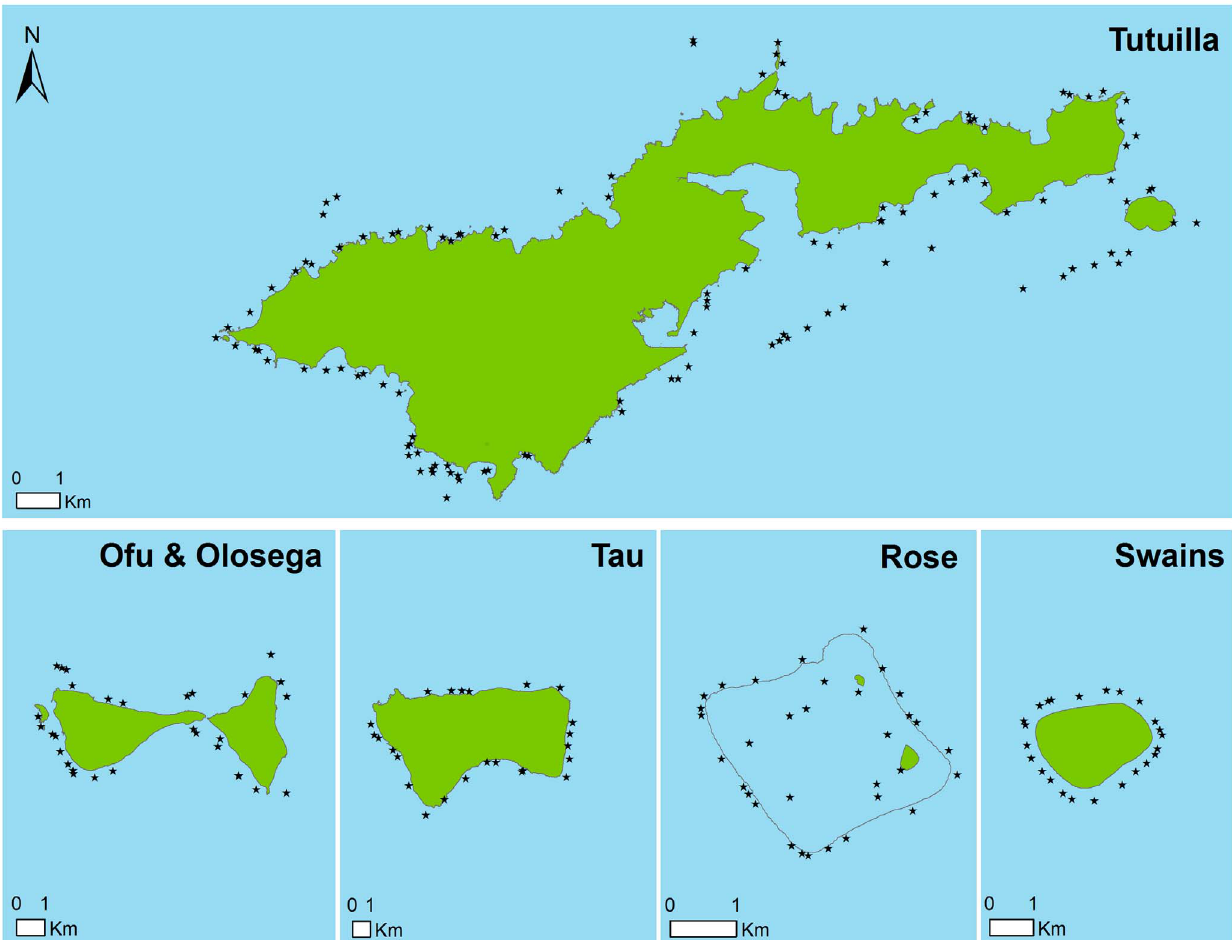
Figure 1. Map showing the location of the survey sites. As part of the NOAA Pacific Reef Assessment and Monitoring Program, 240 sites were selected using a random depth-stratified design over hardbottom substrate in depths of 1–30-m. At each site the fish community was surveyed by means of a stationary point count method and the benthic composition examined via a photo-transect.